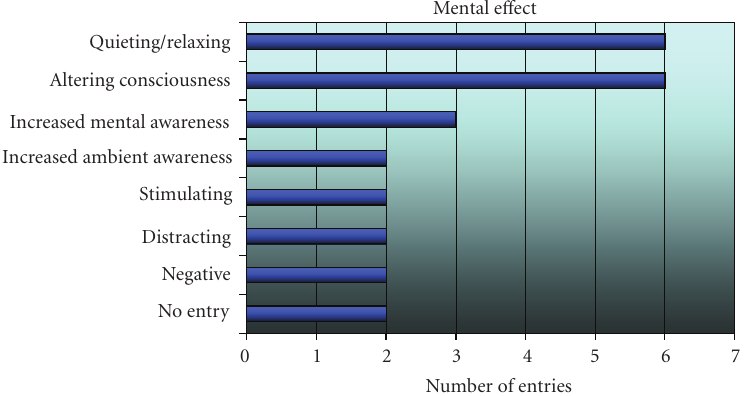
Figure 8: Answer categories in response to the question “What was the mental e ff ect of the